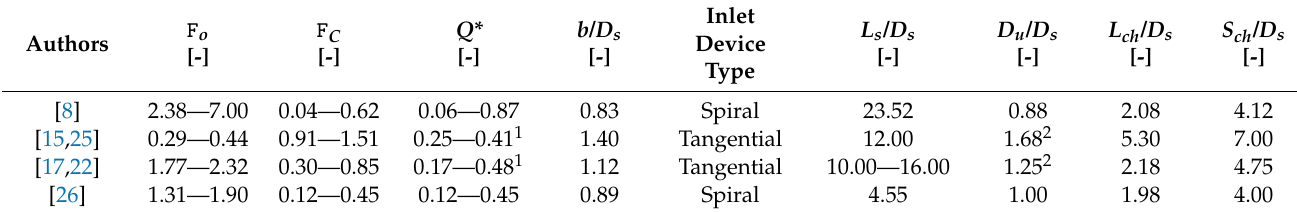
Table 1. Geometrical and hydraulic details of various studies on vortex drop